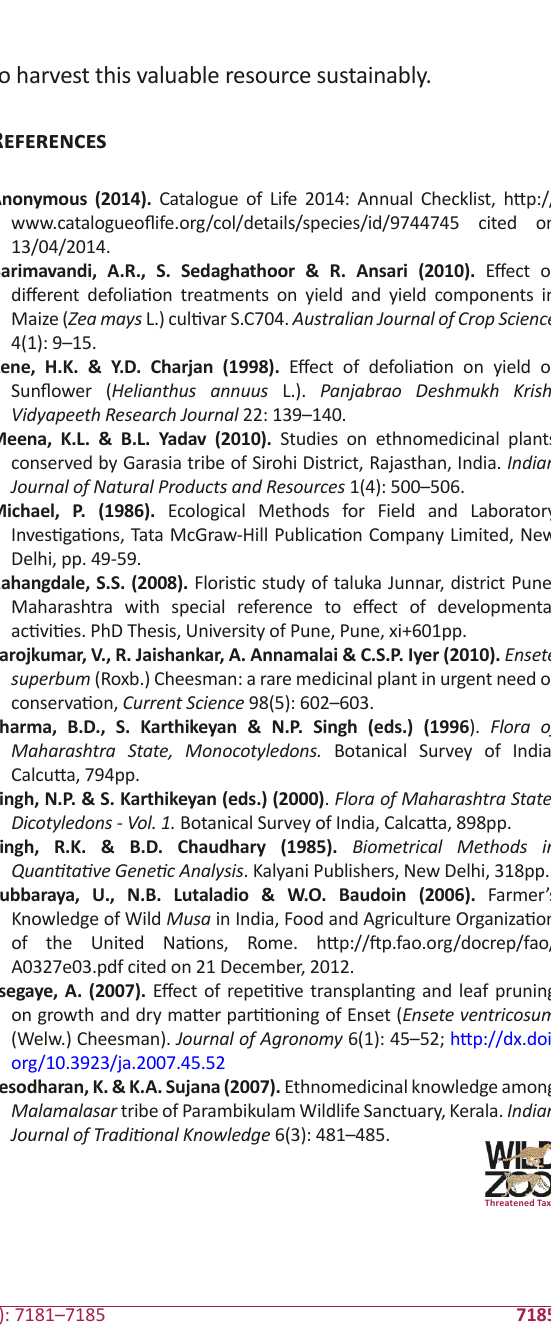
Figure 2. Graphical representation of Ensete superbum at different